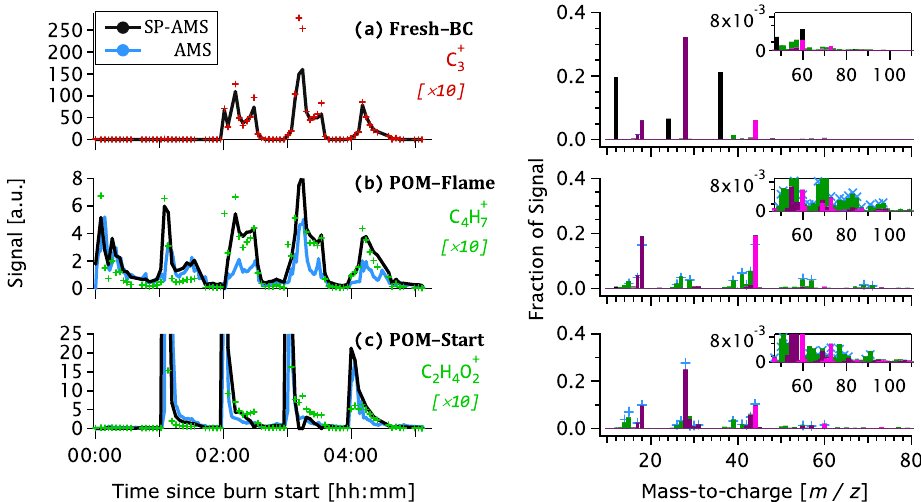
Figure 5. PMF factors for fresh-emissions data. The left column shows SP-AMS factor time series (black) together with AMS time series (blue) and selected SP-AMS tracer ions (symbols). The right column and insets shows the corresponding SP-AMS factor mass spectra using the same colour scheme as Fig. 3: black ions are carbon clusters, green ions are hydrocarbon fragments, and pink/purple are more- or less- oxygenated carbon-containing ions. The right-column blue symbols show the AMS mass spectra for data > 1% (or > 0.1%) of the spectrum in the main panel (or inset). Signals for (c) POM–Start are drawn off-scale to show key structural features. In the mass spectra of (b) , no CO + signal is shown as that species was below its detection limit (see